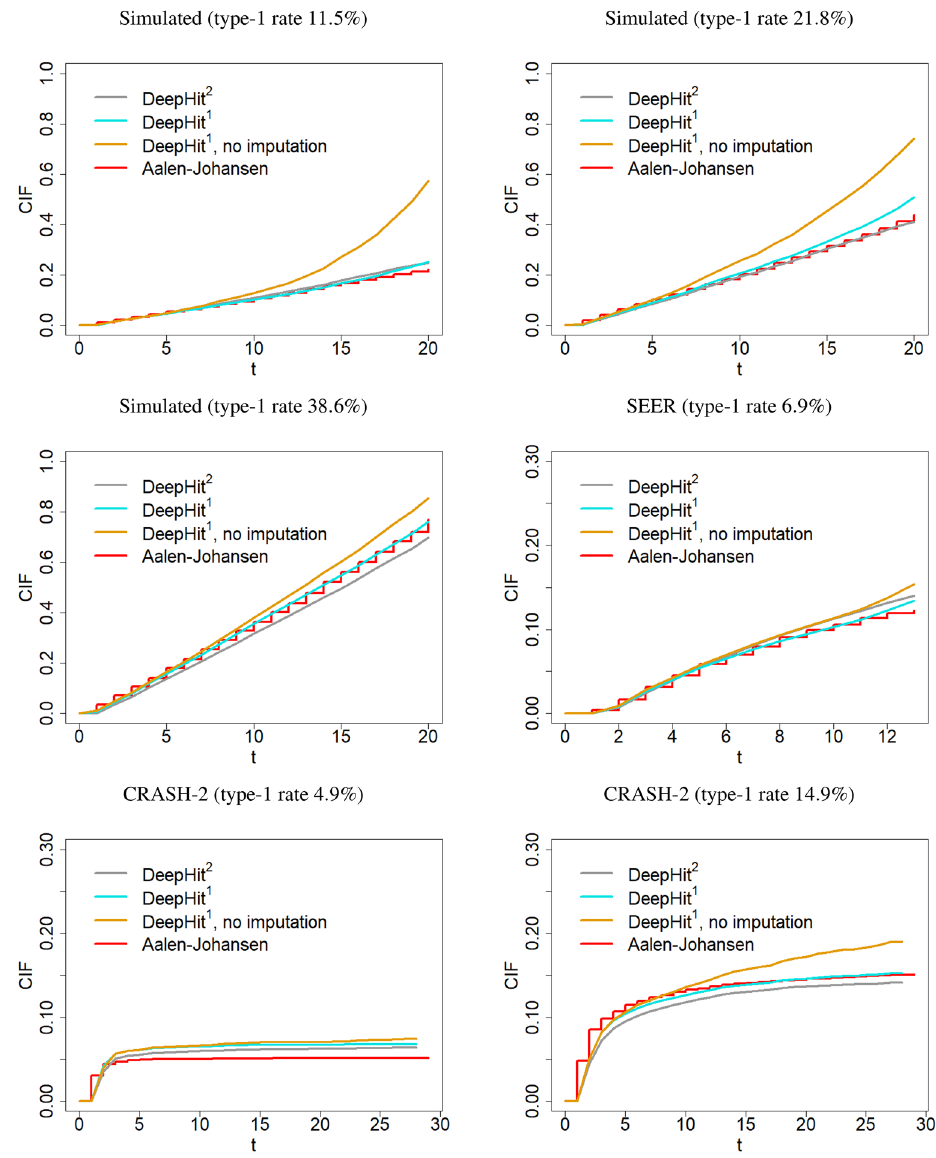
Figure 3. Calibration plots obtained from the test data in Table 1, using the DeepHit architecture. Each plot presents the averaged type-1 cumulative incidence functions as obtained from (i) training the DeepHit 1 with the preprocessed data (cyan), (ii) training DeepHit 1 treating individuals with observed competing events as censored (orange), and (iii) training DeepHit 2 for both the event of interest and the competing event (gray). Red curves refer to the nonparametric Aalen-Johansen reference